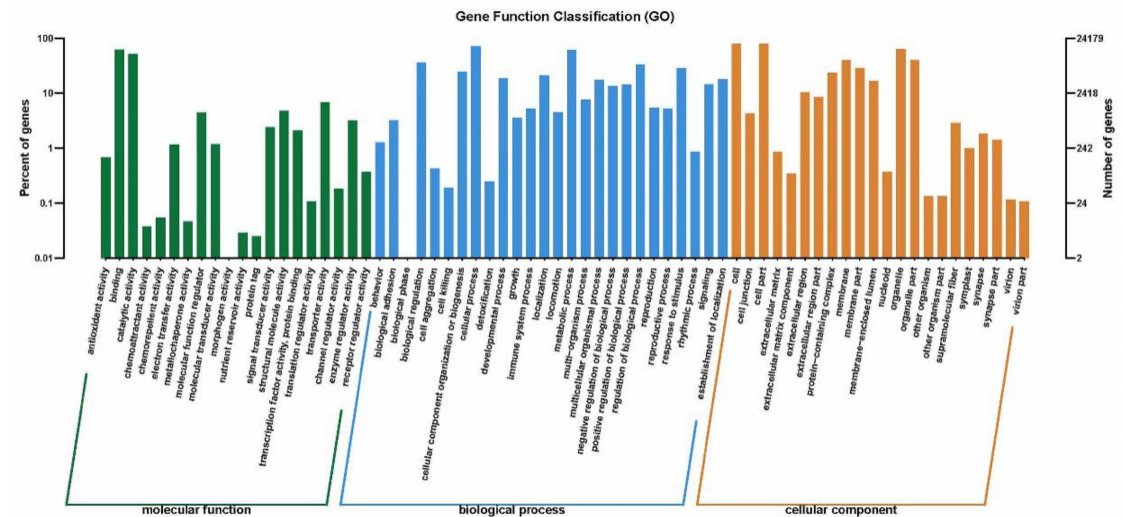
Figure 4. Gene function classification according to GO assignments for the predicted